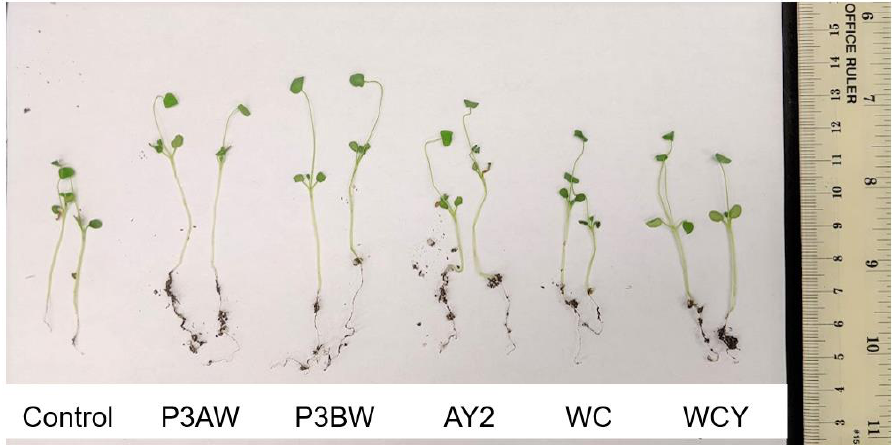
Figure 4. Visual comparison of red clover seedlings inoculated with individual Pseudomonas sp. Strains. Total number of seeds germinated = 14, 18, 21, 22, and 19, from left to right. Statistical analysis confirmed that inoculation with any of the five Pseudomonas sp.